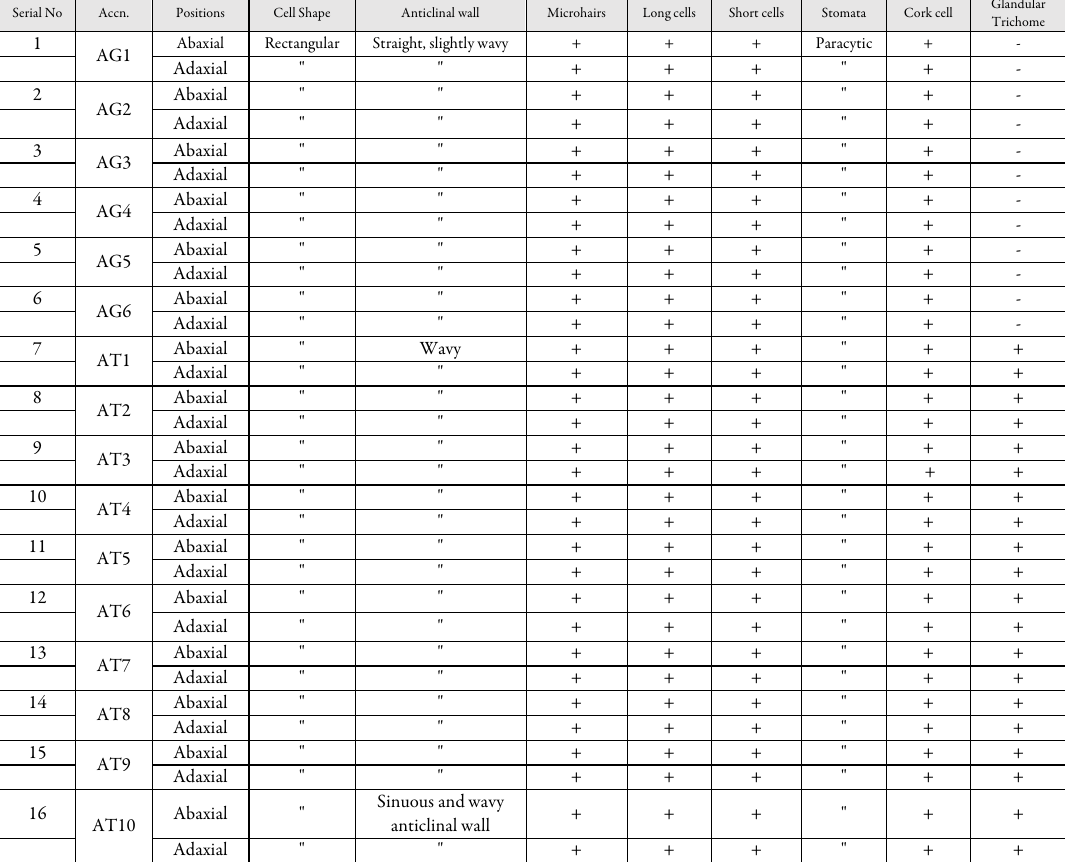
Table. Summary of the leaf epidermal characteristics of all the accessions of Andropogon gayanus- Andropogon tectorum